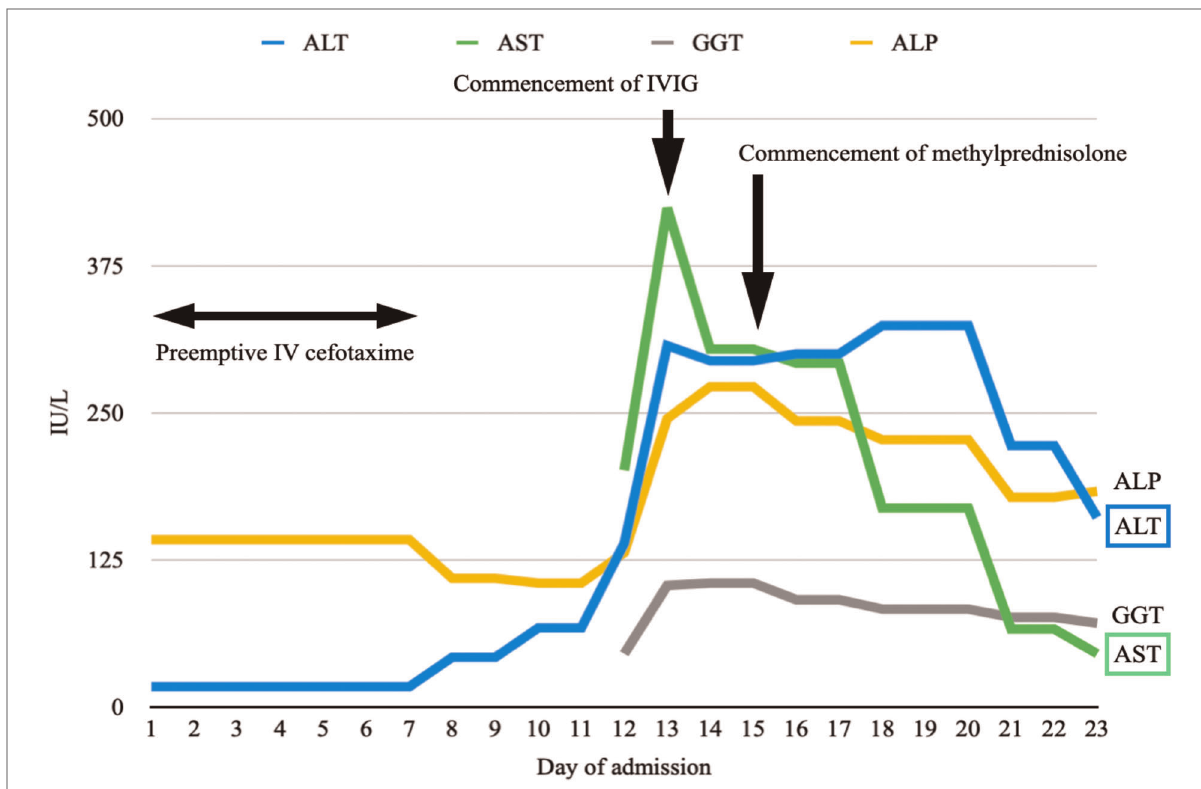
FIGURE 4 A graph illustrating the rise of predominantly ALT and AST since day 8 of admission. They show a downtrend after the commencement of IVIG on days 13 and 14 of admission. ALT elevates transiently after the commencement of methylprednisolone on day 15 before it drops again fi ve days later. Both AST and GGT show a downtrend. ALP remains within the reference range throughout the whole of the